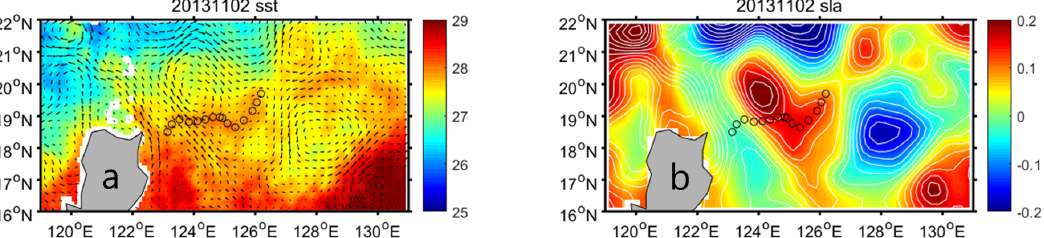
Figure 12. Snapshot of ( a ) SST (color, ◦ C) and geostrophic velocity (vectors); ( b ) SLA (color, in m) and ADT contours on 2 November